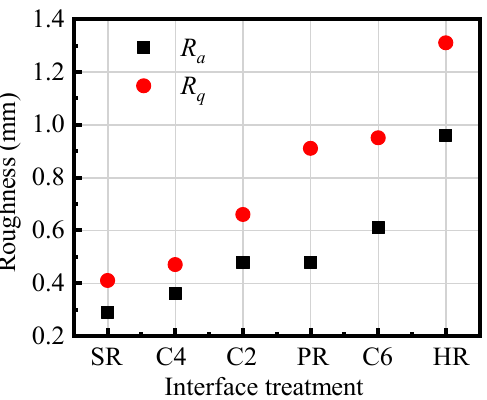
Figure 5. Measured roughness parameters of interfaces treated by different methods. Note: R a is the arithmetical mean roughness, and R q is the surface root mean square roughness.